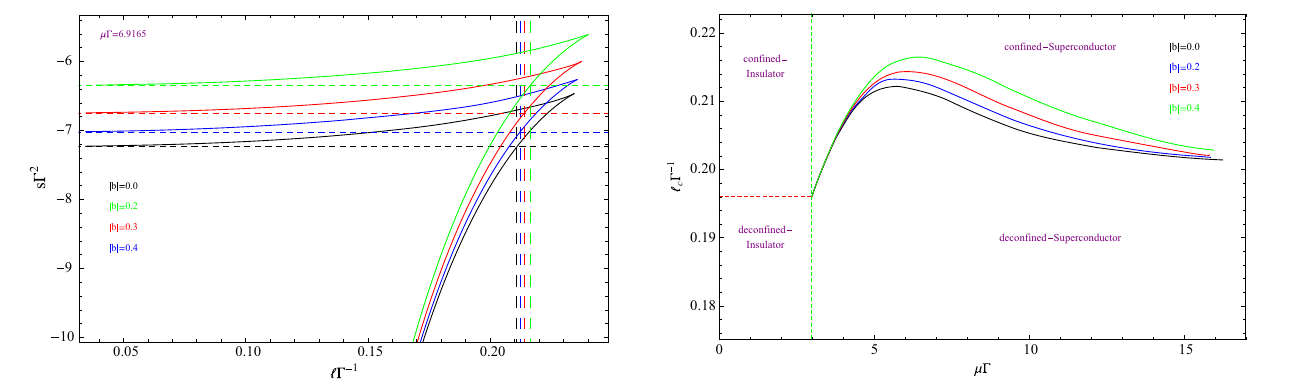
superconductor phase. The left-hand figure corresponds to (cid:16)(cid:10) − 1 = 1 and different b: black curve for | b | = 0 , blue curve for | b | = 0 . 2, red curve for | b | = 0 . 3 and green curve for | b | = 0 . 4. The right-hand figure corresponds to | b | = 0 . 3 and different (cid:16) : green curve for (cid:16)(cid:10) − 1 = ∞ , red curve for (cid:16)(cid:10) − 1 = 0 . 181 and blue one for (cid:16)(cid:10) − 1 = 0 .